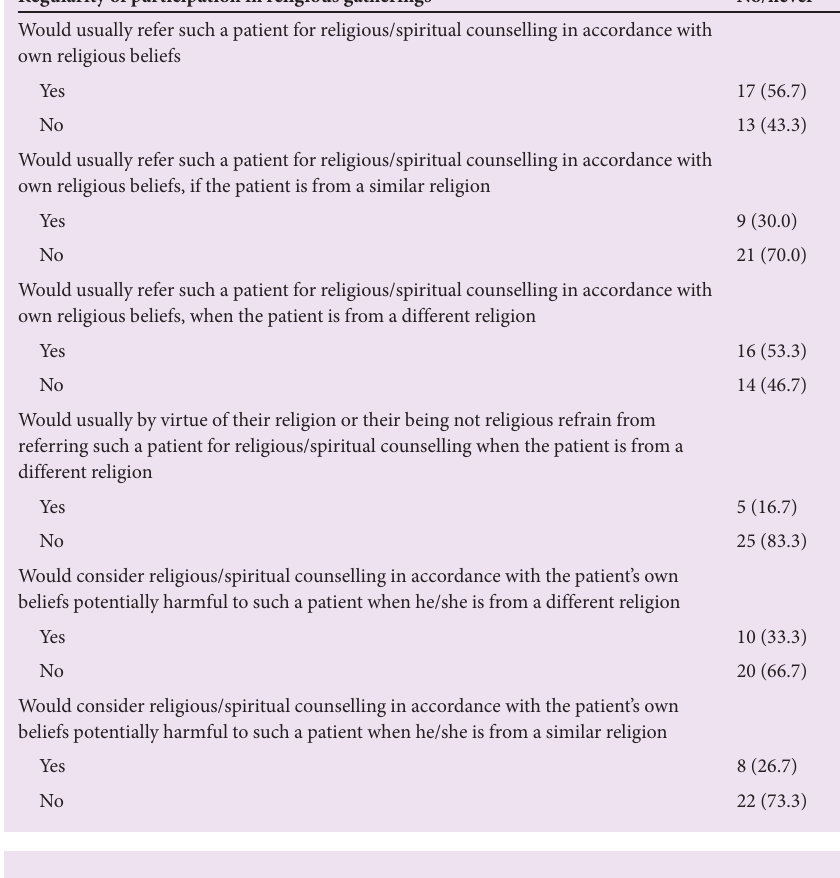
Table 4. Regularity of participation v. referral considerations Regularity of participation in religious